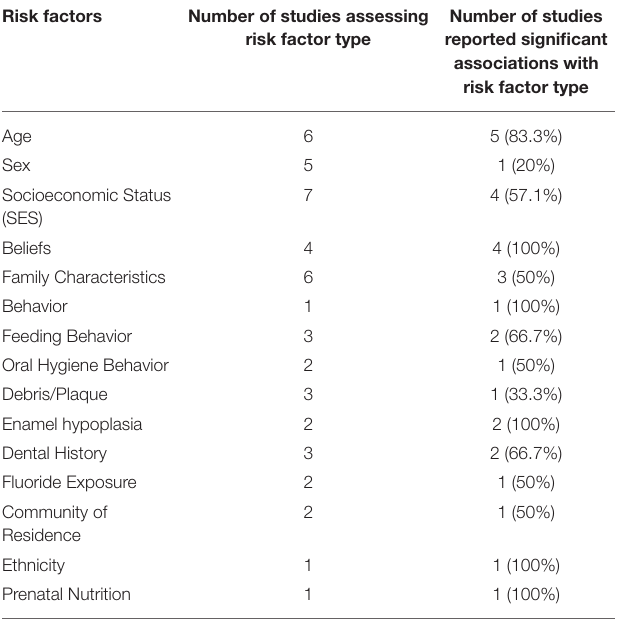
TABLE 3 | Canadian studies using Logistic Regression to assess Caries risk factors. Risk